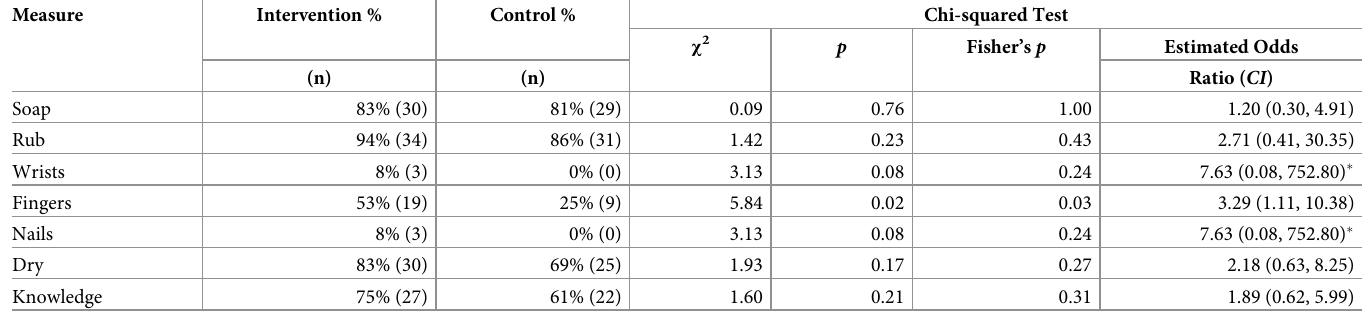
Table 4. Study 2 intervention vs. control: Percentages of participants in the intervention (n = 36) and control (n = 36) groups under eight years of age who demon- strated each handwashing behaviour and whose responses included “germs”.